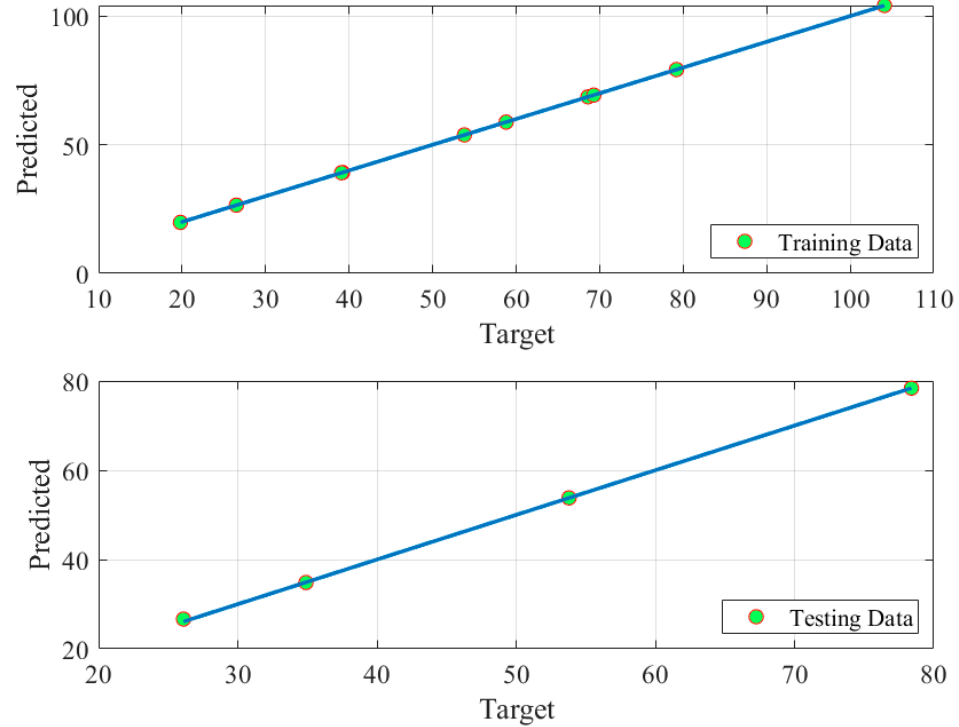
Figure 7. Prediction accuracy of the ANFIS model of the water electrocatalysis process.